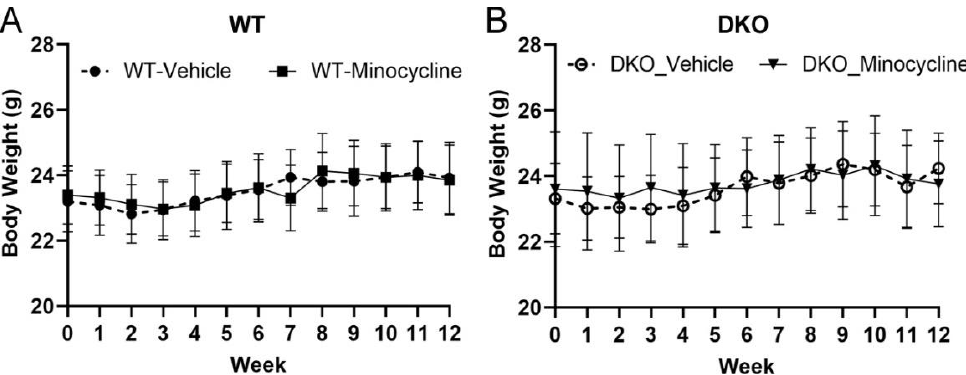
Figure 1. The body weight of wild type (WT, ( A )) and double knockout (DKO, ( B )) mice in vehicle or minocycline treated mice during the 3 months study.